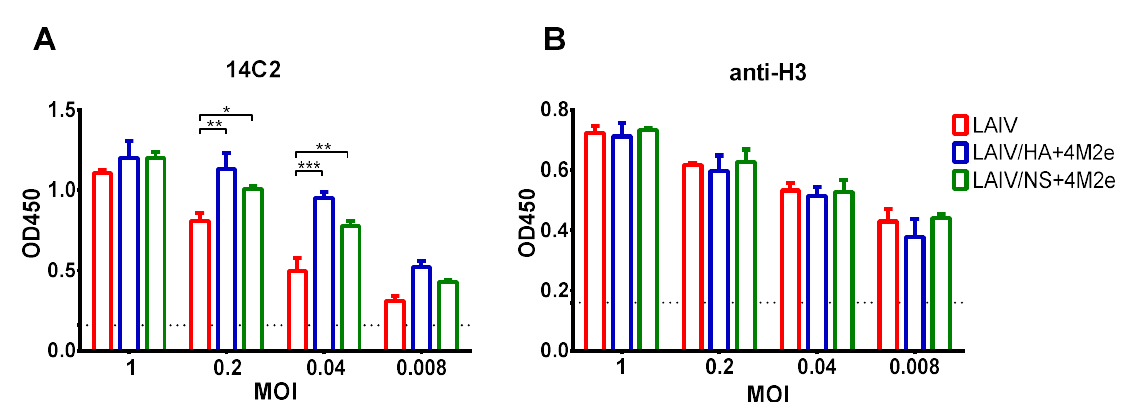
Figure 3. Detection of M2e antigen in infected cells. MDCK cells were infected with various MOIs of the studied viruses and were fixed 24 hpi. Detection of M2e protein was performed using 14C2 monoclonal antibody ( A ). Detection of H3 protein was performed using H3N2 HA-specific monoclonal antibody ( B ). Dashed lines indicate the mean OD 450 values of the uninfected control wells. Data were analyzed by two-way ANOVA with Tukey’s post-hoc multiple analyses test. * p < 0.05; ** p < 0.01; *** p < 0.001.